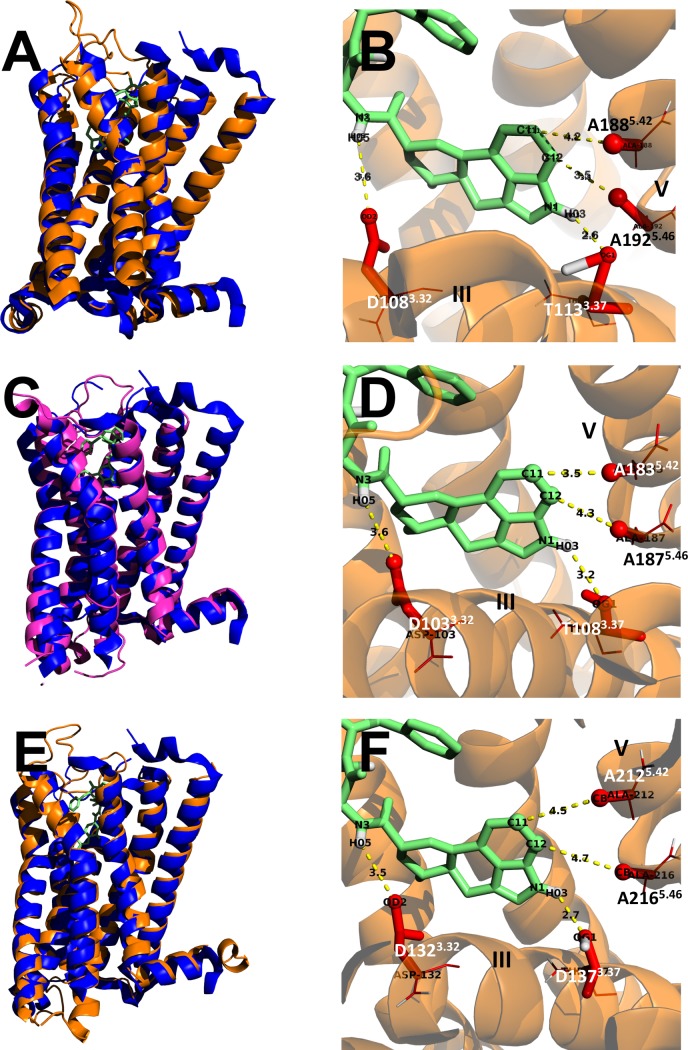
Molecular modeling of serotoninergic receptors from cestodes.The structural similarities between three cestode receptors and the published structure of the serotoninergic receptor from human (4IAR) are shown. A) Model of the serotonin receptor 5-HT7Egran1 (Brown) superposed to the published structure of the human serotonin receptor 5-HT1B (blue). B) Close view of the putative ergotamine interaction with residues of the transmembrane domains III and V from 5-HT7Egran1 (lateral chains of the amino acids involved are indicated in red), molecular distances between atoms are indicated. C) Model of 5-HT7Egran2 (violet) superposed to 5-HT1B (blue). D) Close view of the ergotamine interaction with some residues of the transmembrane domains III and V from 5-HT7Egran2. E) Model of 5-HT7Mco1 (Brown) superposed to 5-HT1B (blue). F) Close view of the ergotamine interaction with some residues of the transmembrane domains III and V from 5-HT7Mco1. In all the representations, the molecule of ergotamine was marked in green and the residues in transmembrane domains potentially involved in ergotamine interaction were marked in red.